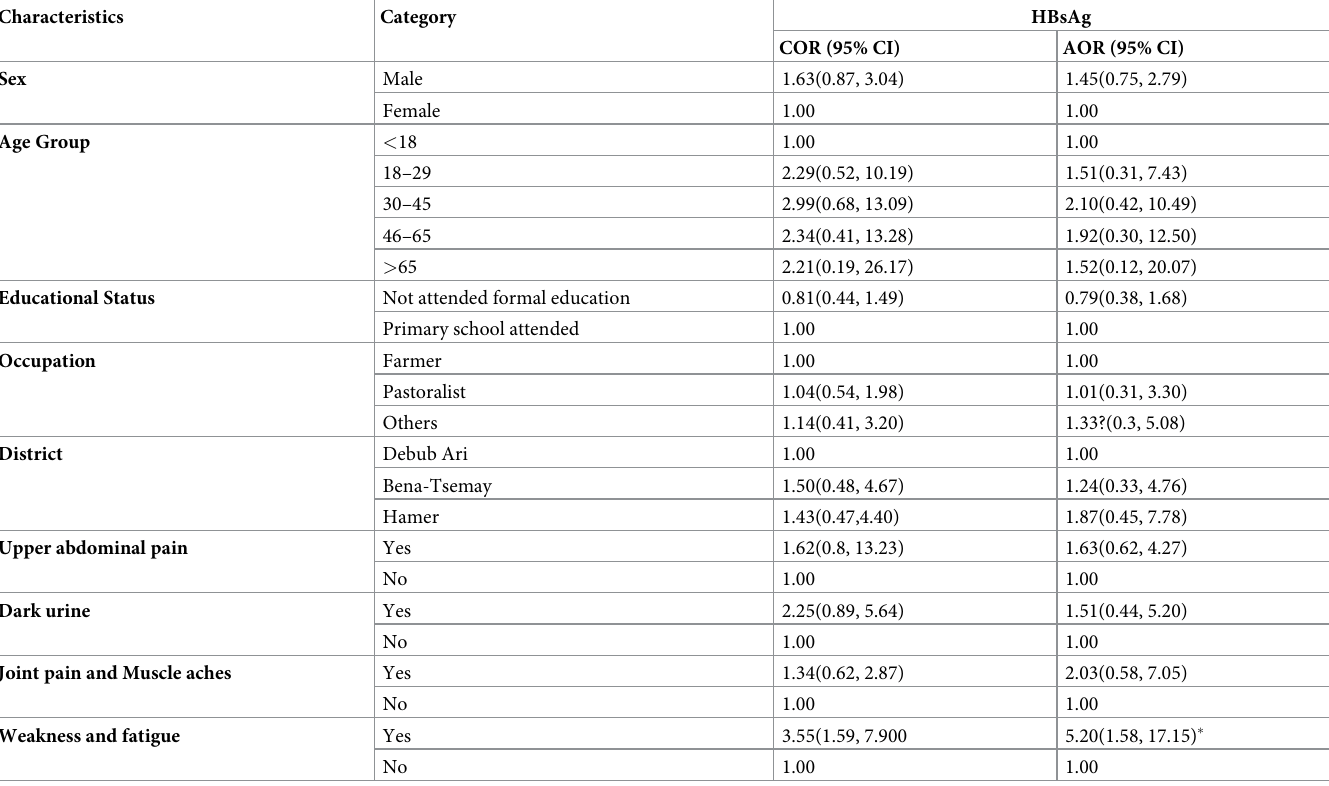
Table 4. Independent predictors of HBV